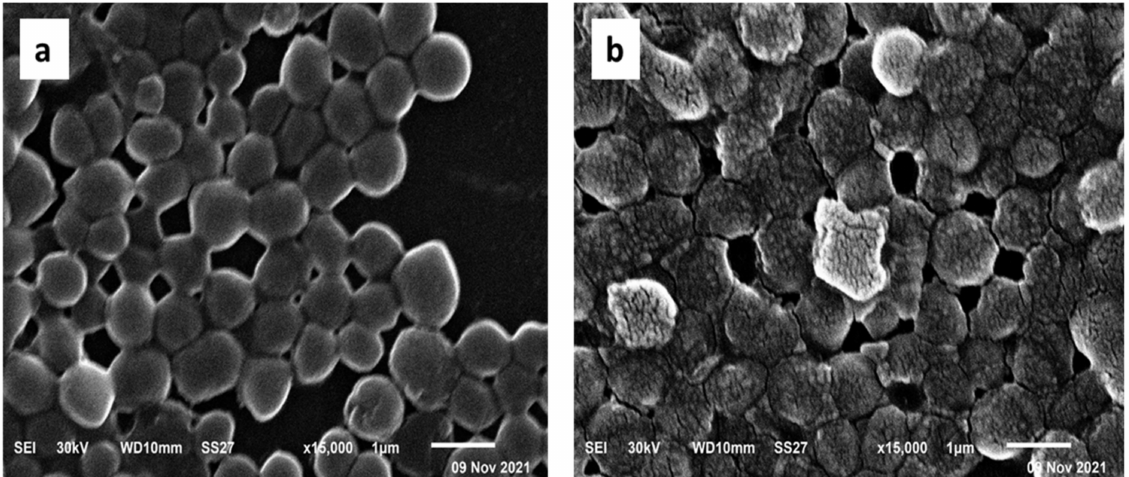
Figure 11. Scanning electron micrograph of a representative S. aureus isolate ( a ) before treatment and ( b ) after treatment with the green-synthesized